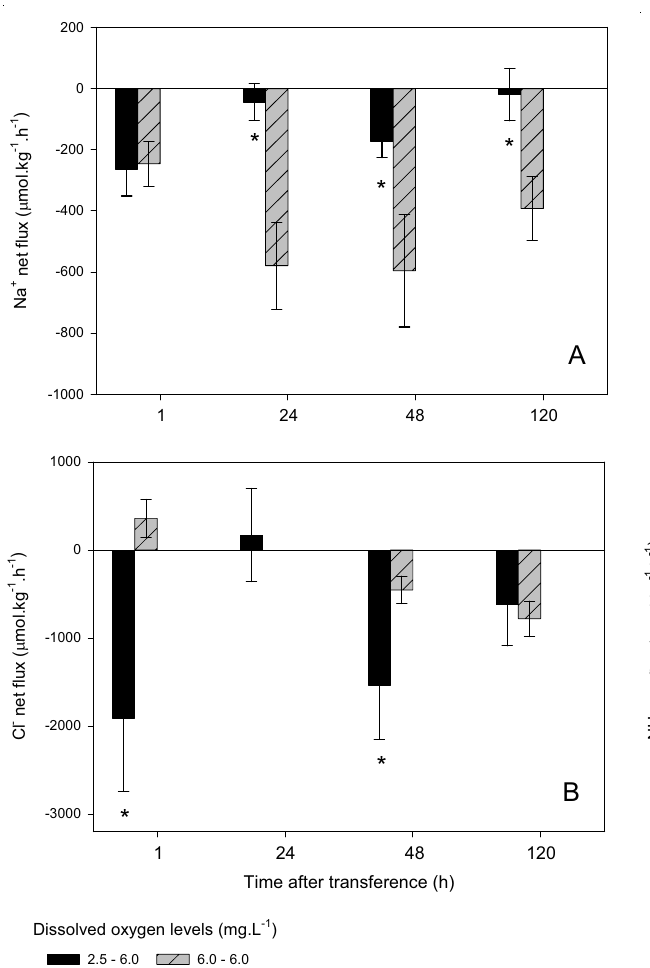
Dissolved oxygen levels (mg.L -1 ) 2.5 - 6.0 Fig. 4. K + (A) and NH 4+ (B) net fluxes of silver catfish juve- niles acclimated to 2.5 (2.5 – 6.0) or 6.0 (6.0 – 6.0) mg.L -1 dis- solved oxygen levels for three weeks and transferred to aquaria with 6.0 mg.L -1 dissolved oxygen levels. Data expressed as mean ± SEM. Positive values indicate net influxes, and nega- tive values net effluxes. * significantly different from juve- niles transferred to 6.0 mg.L -1 at the same time after transfer- + ) or by ence by one-way ANOVA and Tukey test (NH 4 Kruskall-Wallis Anova and Mann-Whitney test (K + ) (P <